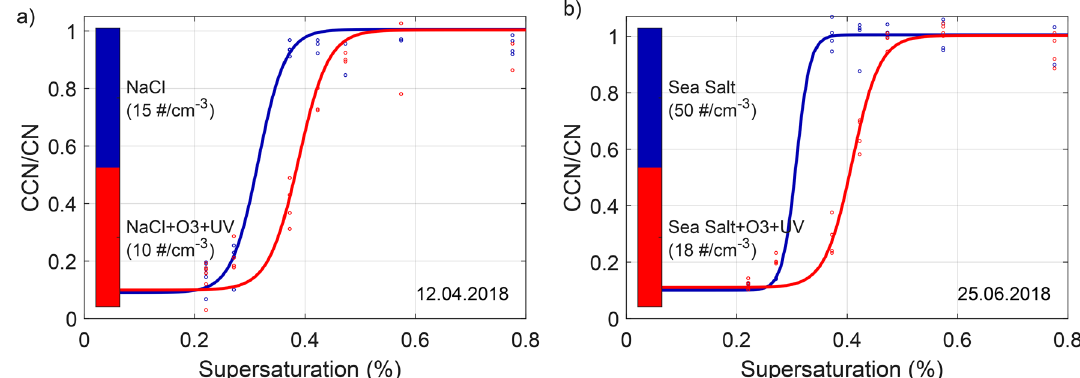
Figure 3. Effect of ageing on CCN activation potential. Measurement of the critical supersaturation for monodisperse particles of D dry = 50 nm. Results for NaCl are illustrated in ( a ) and for sea salt in ( b ). The blue lines show CCN activation at the initial state of the experiments (fresh NaCl and SSA), while the red lines illustrate CCN activation after 3 hours of ageing in the presence of O 3 and UV lights (aged NaCl and